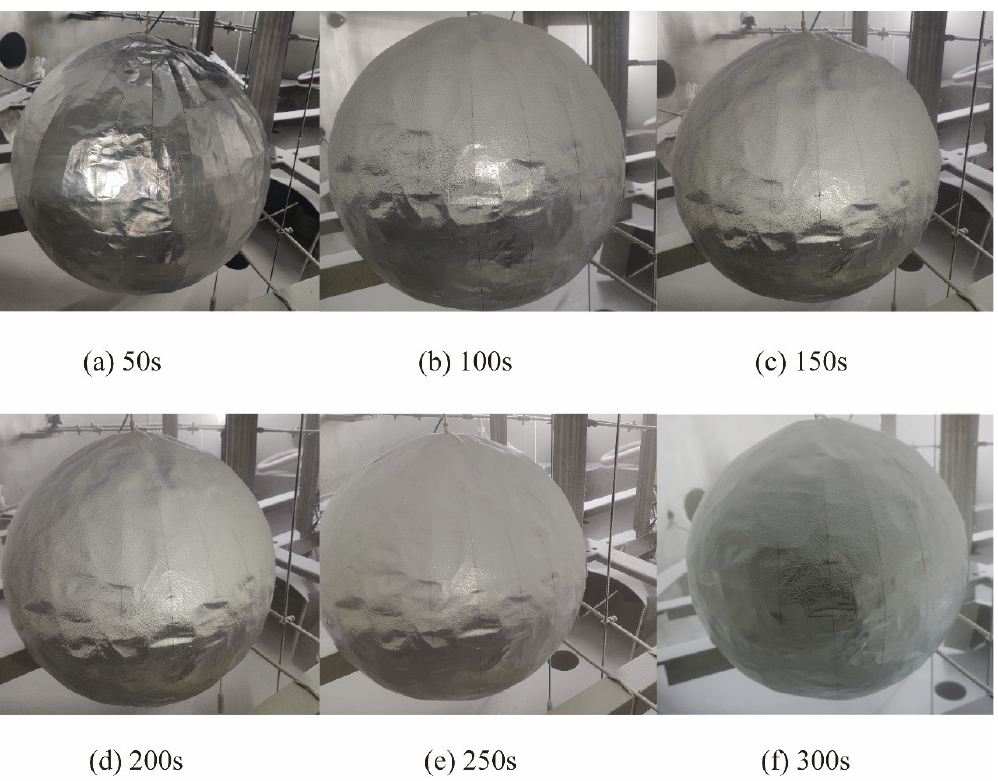
Figure 5. Ice accretion of the scaled airship at ( a ) 50 s, ( b ) 100 s, ( c ) 150 s, ( d ) 200 s, ( e ) 250 s, and ( f ) 300 s during condition 1.